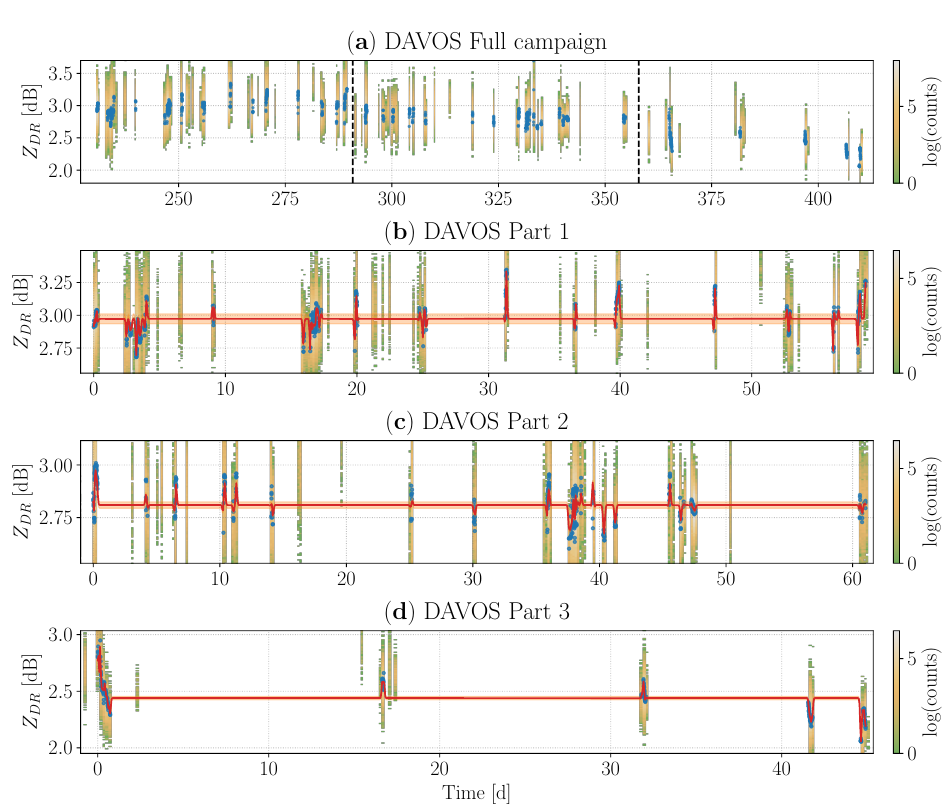
Figure 9. Temporal evolution of the calibration for DAVOS. ( a ) The median Z DR value (blue dots) for the whole time span of the campaign. The dots are superimposed to the 2-dimensional histogram of the couples ( t , Z DR ) , in logarithmic scale. The dashed vertical lines illustrate the three parts in which the campaign has been split. ( b ) The median Z DR value (blue dots), as well as the bias (red curve), and its uncertainty (orange area) for the first part of the campaign, analogously to Figure 5. Panels ( c ) and ( d ) show the same quantities for the second and third part of the campaign,